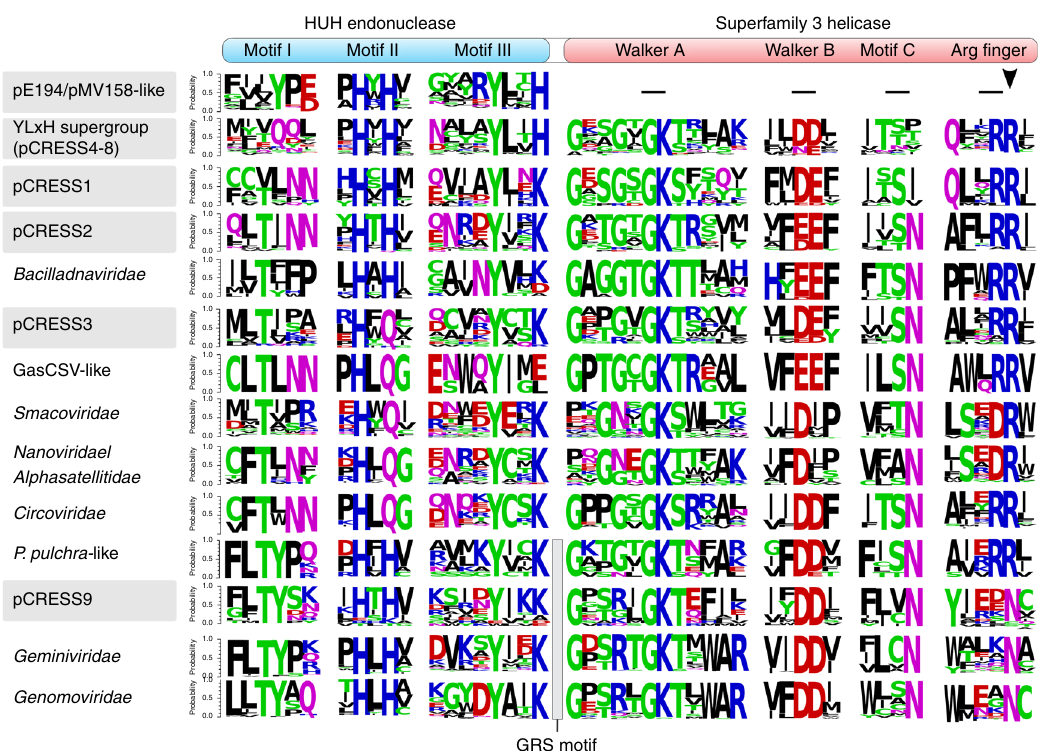
Fig. 3 Conserved sequence motifs of Rep proteins. Bacterial Rep groups are depicted in gray background. Residues are colored by their chemical properties (polar, green; basic, blue; acidic, red; hydrophobic, black; neutral, purple). The Rep groups were manually ordered according to the pairwise similarity in the aligned motifs. The HUH endonuclease and SF3 helicase domains are delineated at the top of the fi life. Notably, pCRESS9 and P. pulchra plasmids are not linked with other plasmids but are rather connected to the rest of the